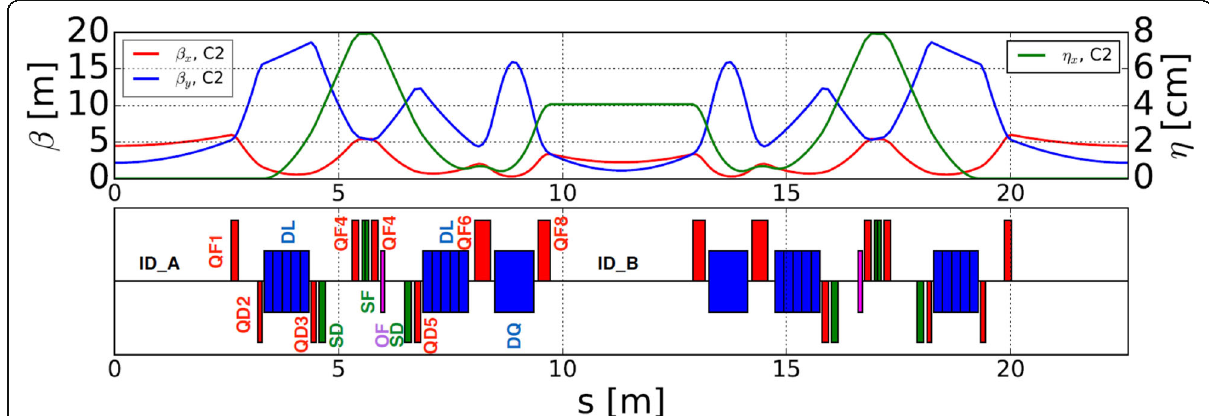
Fig. 12 Variant multi-bend achromat lattice